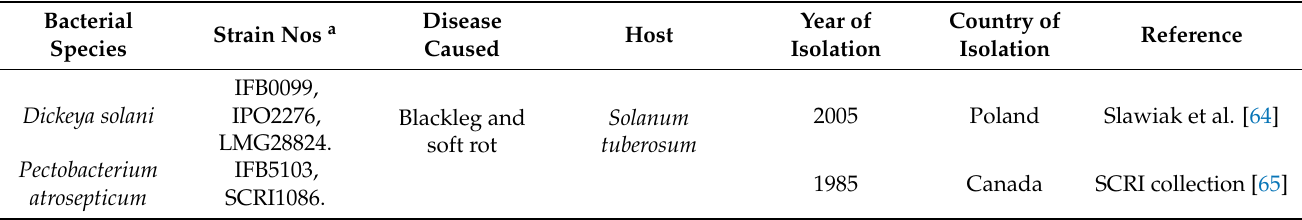
Table 5. Phytopathogenic bacteria used in this